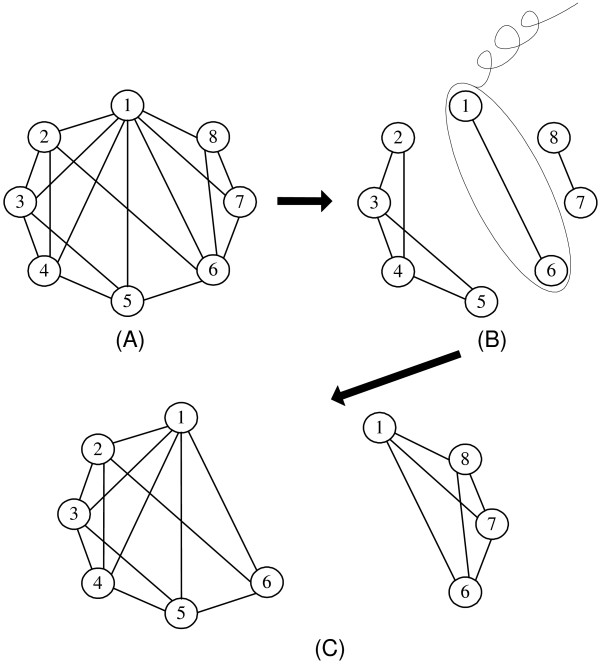
The diagram of our Core-removal algorithm. In this example, we assume that (A) shows the core graph of vertex 1's neighborhood graph, denoted as CG1. The density and average degree of CG1 is 0.607 and 4.25 respectively. In (B), the core vertices of CG1, {1, 6}, are removed from CG1 and two connected components are left in the remaining graph. In (C), {1, 6} are added back into each connected component. Two subgraphs with vertices {1,2,3,4,5,6} and {1,6,7,8} are obtained and finally returned.